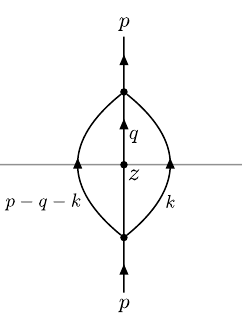
. All momentum flows up from the lower to the L